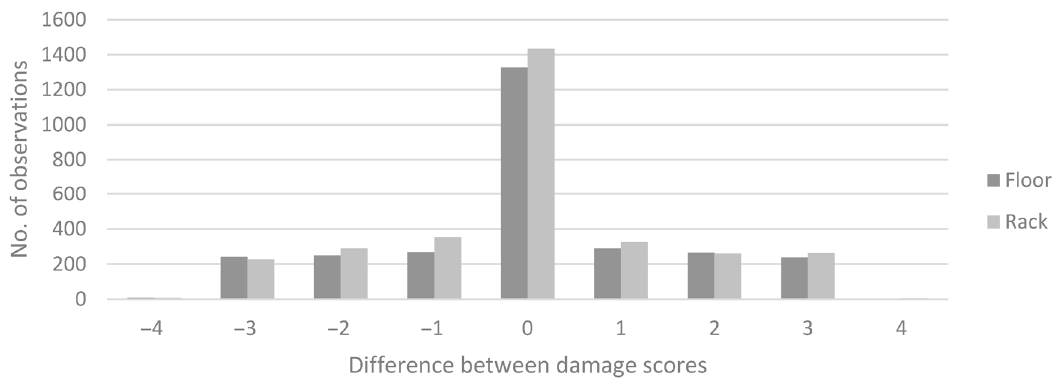
Figure 4. Difference in tail damage between two adjacent weekly scorings of tail damage on the same pig in the Floor and Rack treatments. n = 6053.